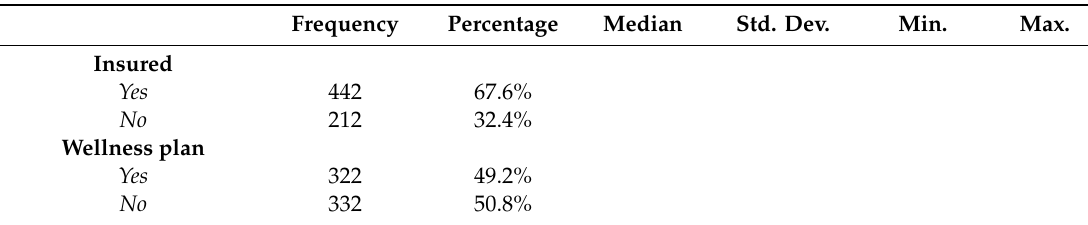
Table 2. Summary statistics of variables used in the econometric analysis. Frequency and percentages are provided for categorical variables, and median, standard deviation, minimum, and maximum are provided for continuous